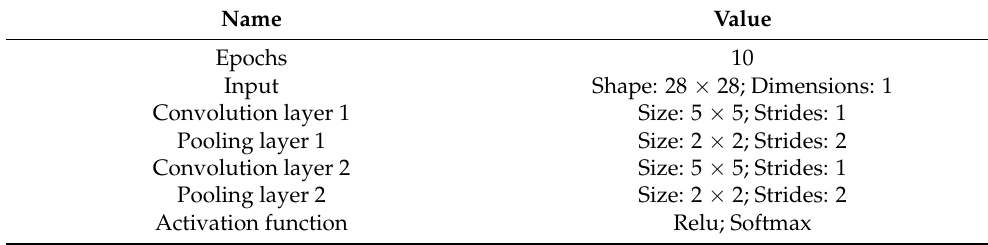
Table 3. Parameter settings of the LetNet-5 convolutional neural network that remain